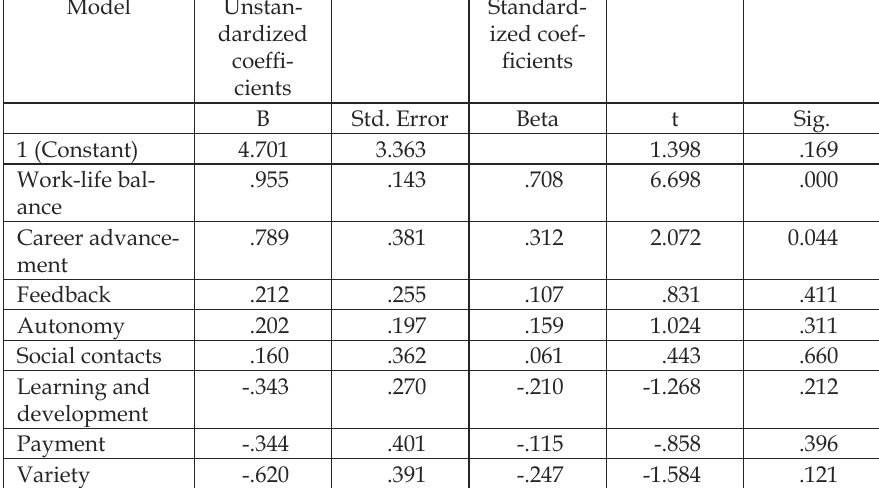
Tab. 8. Predictors of the tendency to leave the organization for the respondents above 35 years. Coef (cid:222)